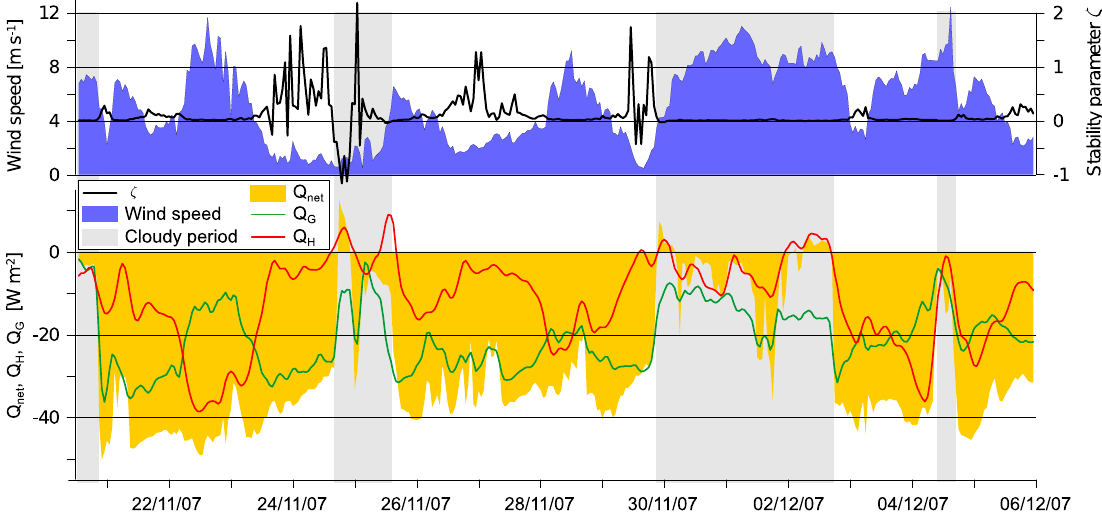
Fig. 6. Hourly averages of Q net , Q H and Q G during the transition from early to polar winter in 2007 (lower graph). Presumably overcast conditions are shaded. Measurements of the wind speed and the stability parameter ζ are depicted in the upper